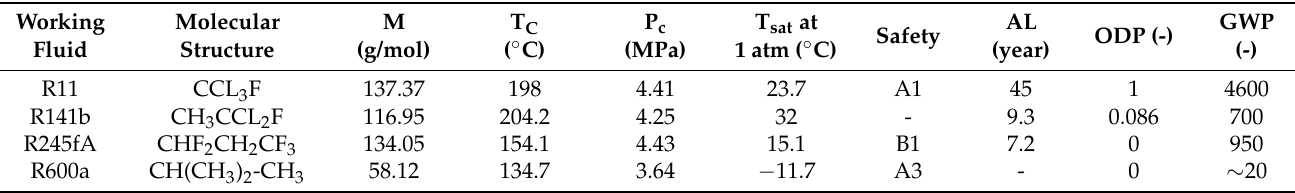
Table 1. Thermodynamic, safety, and environmental properties of candidate refrigerants for the solar-assisted refrigeration system